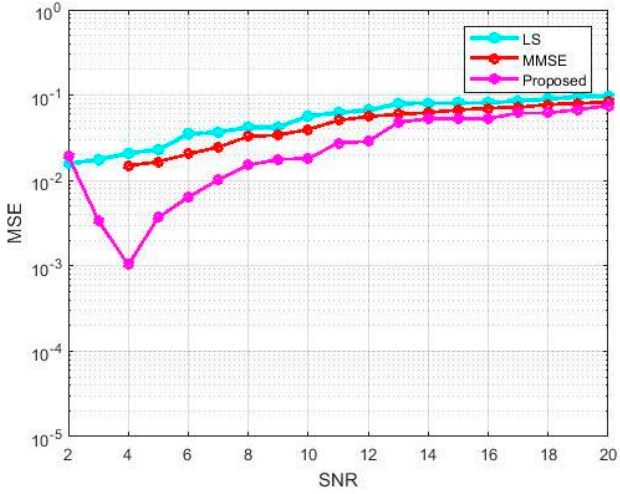
Figure 8. Performance measure for mean square error (MSE) vs. signal-to-noise ratio (SNR).